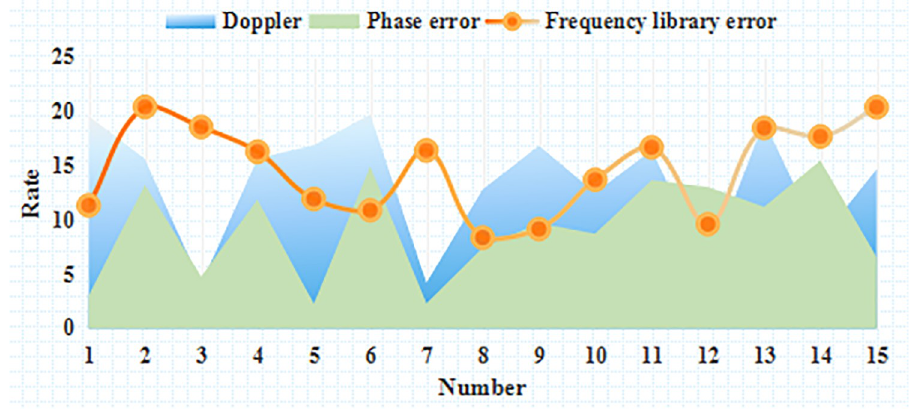
Fig 5. Lower rating.